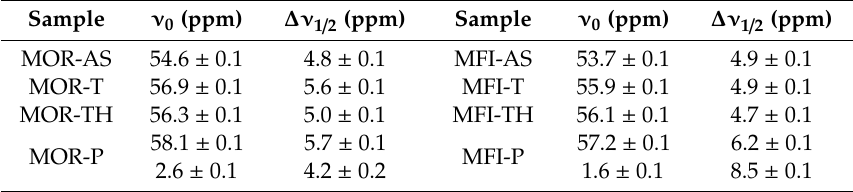
Table 3. 27 Al NMR chemical shift ( ν 0 ) and line width at half maximum ( ∆ ν 1 / 2 ) in the studied samples.